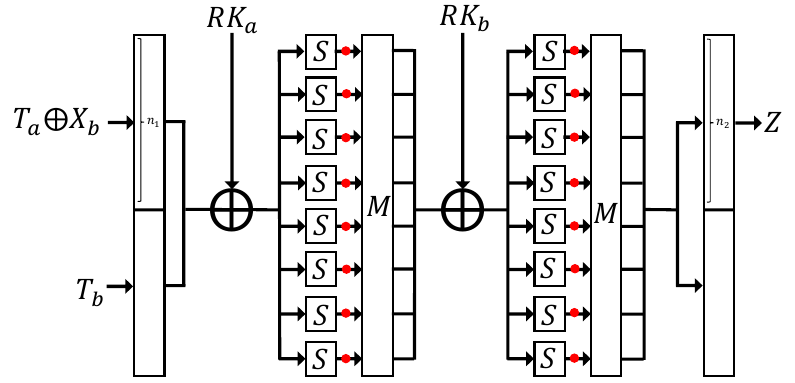
Figure 4. Attack points of CPA on